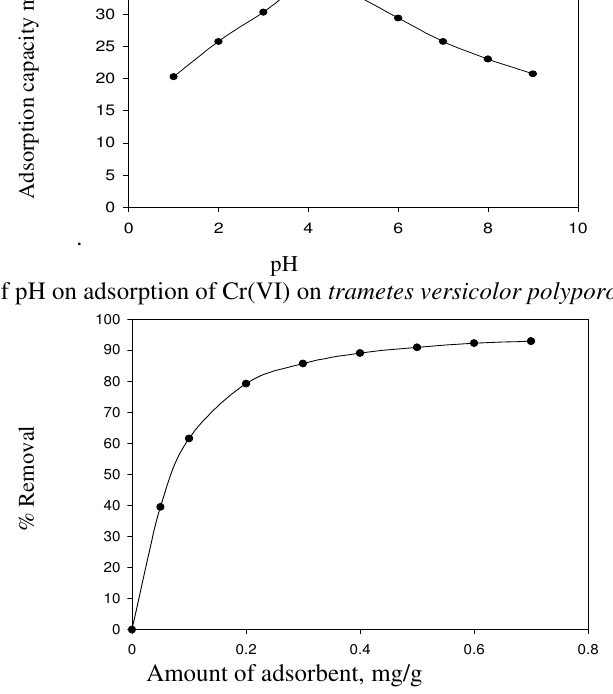
Figure 3 . Effect of amount of trametes versicolor polyporous fungi on percent removal of